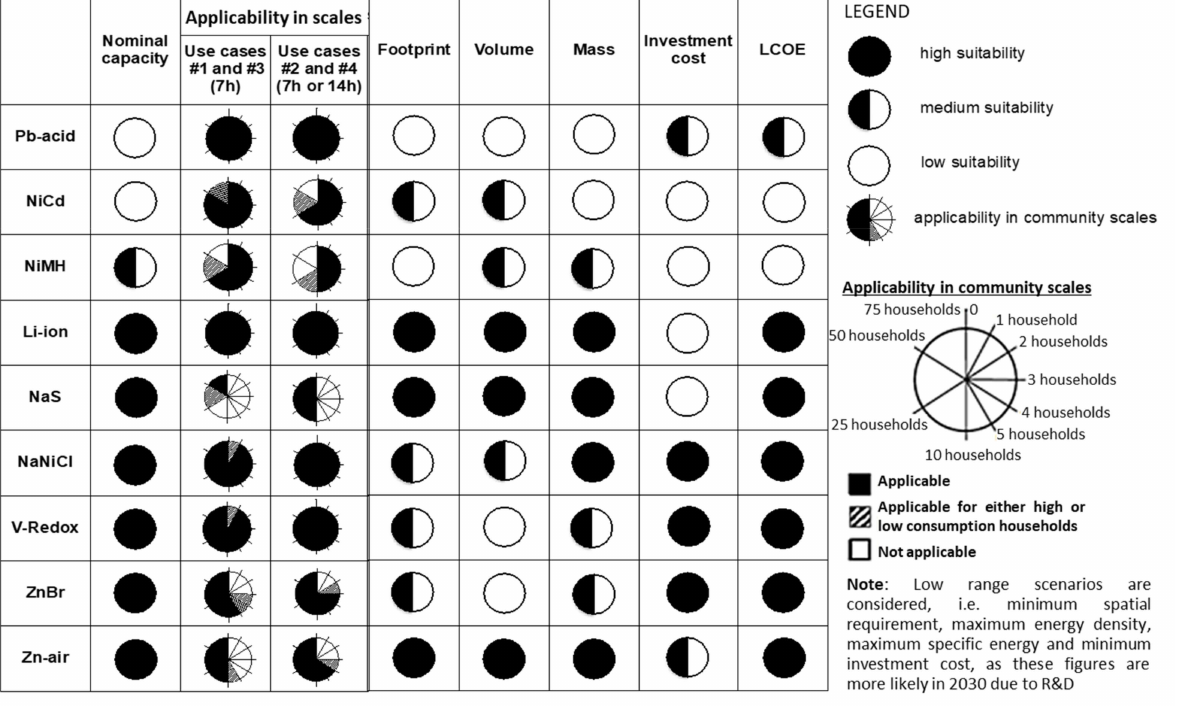
Figure 10. Suitability criteria for battery technologies with sub-daily storage in all case